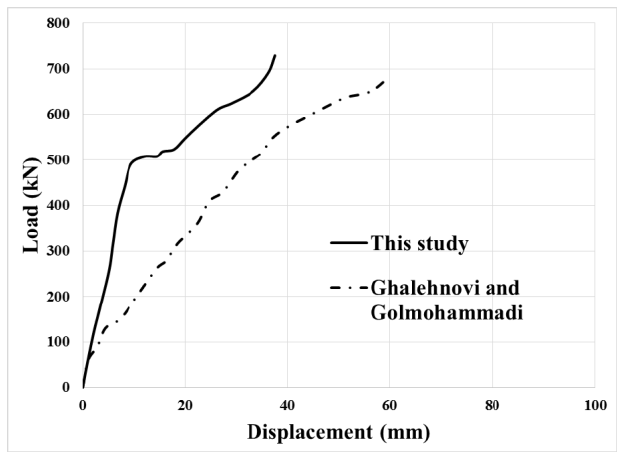
Figure 18. The comparison of the load-displacement curve of SCS slabs with stud bolt and CSC